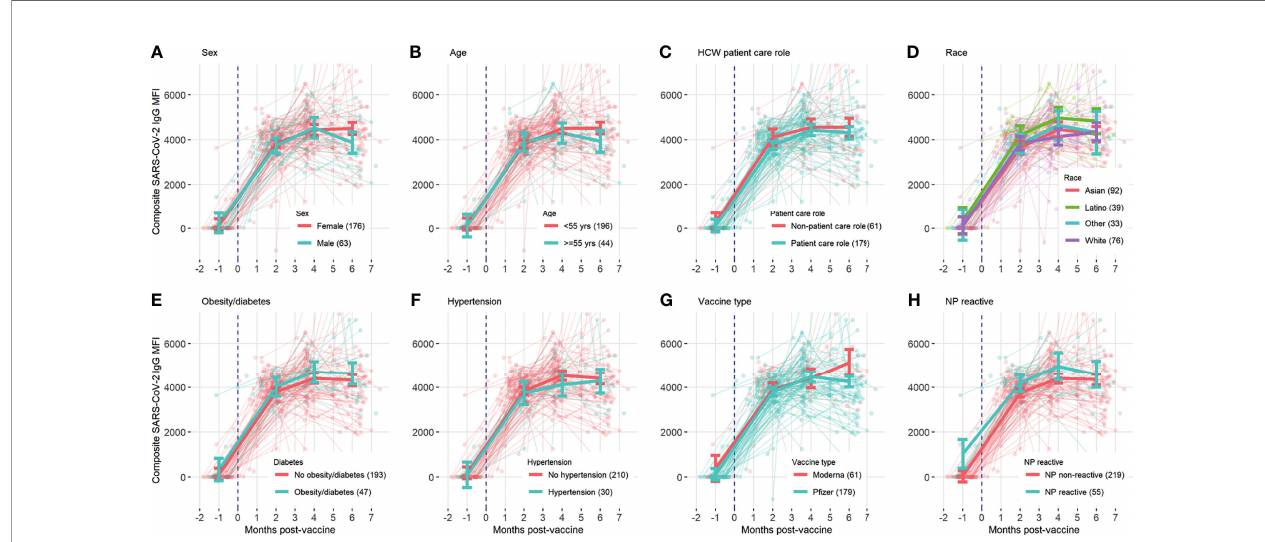
FIGURE 2 | Composite SARS-CoV-2 IgG levels over time, with background lines representing individual study participants and thick solid line representing mean antibody level at baseline, 2 months, 4 months, and 6 months with error bars representing 95% con fi dence intervals, compared for subgroups divided by (A) sex,